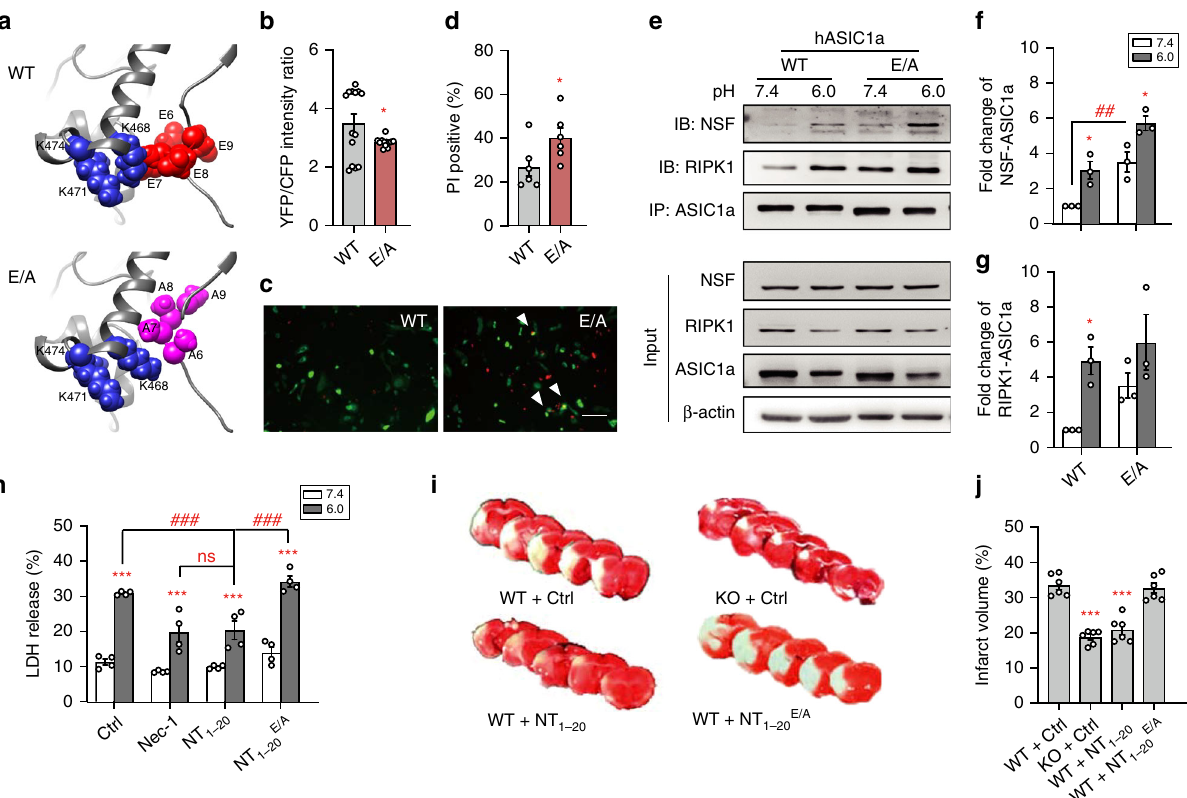
Fig. 6 E 6 EEE 9 at distal N-terminus of ASIC1a are critical for intracellular auto-inhibition. a Rosetta model of closed state ASIC1a suggests that negatively charged glutamate residues (E 6 EEE 9 ) are juxtaposed to positively charged lysines (K 468 , K 471 , and K 474 ) in the CT death motif, forming electrostatic interactions (upper). The distance between beta carbons of E 7 and K 468 is ~4.7 Å. With E → A substitutions at E 6 EEE 9 (lower), ASIC1a-NT moves apart from the lysines at CT death motif. ( b ) The E/A mutant exhibited lower FRET than WT ASIC1a at pH 7.4. CFP and YFP were tagged at NT and CT, respectively. The YFP/CFP emission ratios were acquired under the same conditions using identical settings. n = 12 – 14, * p < 0.05 vs . WT by unpaired t test. c , d Expression of E/A mutant in CHO cells resulted in more cell death than WT ASIC1a at pH 7.4. Representative images of PI-stained cells ( c ) and quanti fi cation of PI-positive CHO cells ( d ). n > 200 transfected neurons ( green ) counted for each. Scale bar, 20 µ m. * p < 0.05 vs. WT by unpaired t test. e Co-IP experiments of transfected CHO cells showing that E/A mutant exhibited increased association with NSF and RIPK1 at pH 7.4. f , g Summary data for ASIC1a-NSF ( f ) and ASIC1a-RIPK1 ( g ) association as determined in ( e ). Data are normalized to NSF/ASIC1a and RIPK1/ASIC1a of WT group at pH 7.4, respectively. n = 3, * p < 0.05 vs . corresponding pH 7.4, ## p < 0.01 vs. WT, by ANOVA. h LDH assay showing that the E → A substituted NT 1 – 20